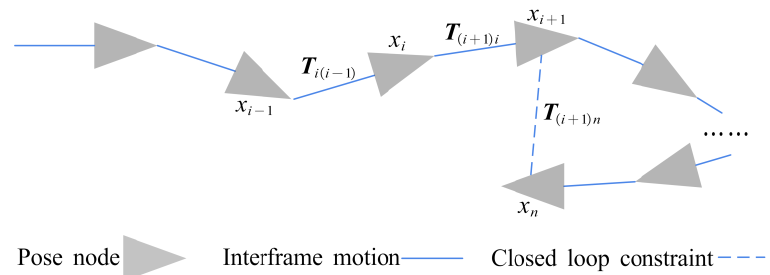
Figure 6. Optimized model of the pose